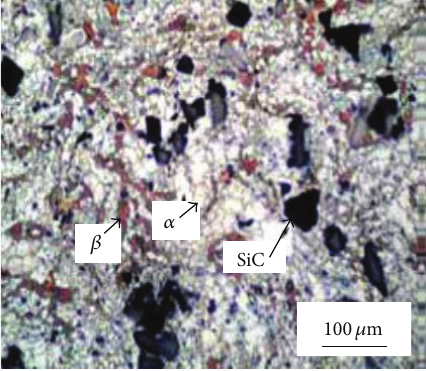
Figure 3: Micrograph of Mg-8Li/SiC [10].